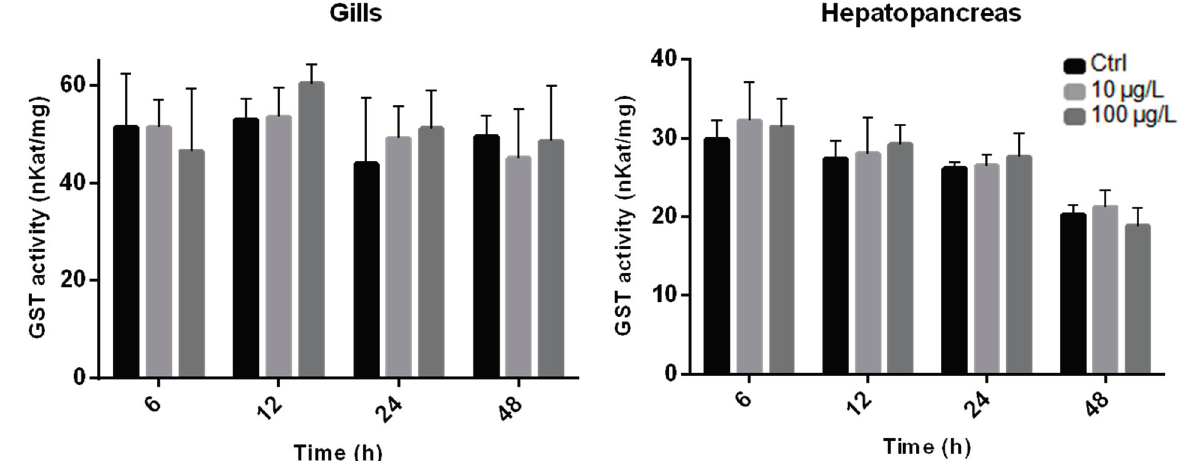
Figure 2. Total Glutathione Transferase (GST) activity (nKat/mg of protein) in R. philippinarum hepatopancreas and gills exposed to pure MC-LR over a period of 48 h. Black columns represent Control (Ctrl) group, light grey columns represents low-exposure group (10 µg/L MC-LR) and dark grey columns represent high-exposure group (100 µg/L MC-LR) (bars show standard